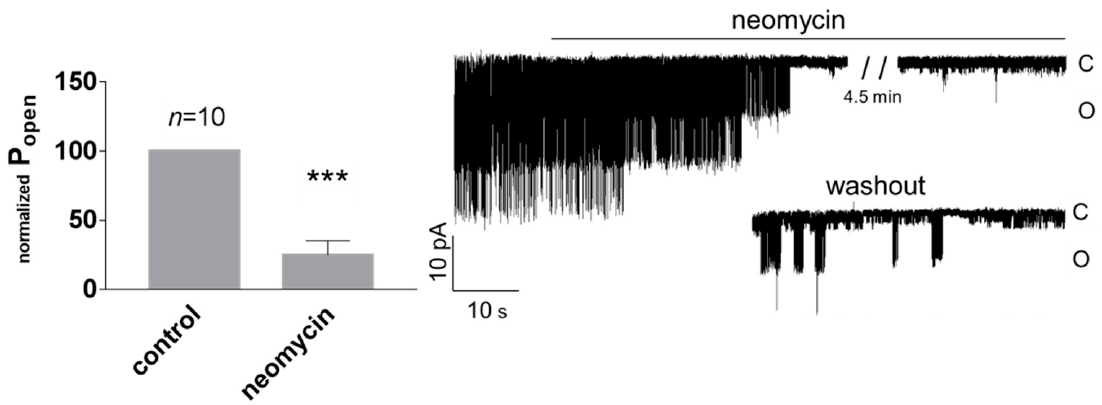
Figure 4. TREK-2-like channels are inhibited by polycationic neomycin (15 µ g/mL) in excised patches. The control solution was exchanged for the solution with neomycin. Both solutions contained 0.1 mM Ca 2+ . P open was normalized in comparison with P open in the control solution, which was set at 100%. P open for recordings at 50 mV and − 50 mV was pooled together. *** p < 0.002, one sample t-test. Original single-channel recordings at − 50 mV at the following conditions: control, neomycin, and washout. The traces were filtered with a low-pass filter set at 1 kHz. Phospholipase C cleaves PI(4,5)P2 to produce second messengers: IP3 and DAG. To further test whether the PI(4,5)P2 ‐ dependent pathway is involved in TREK ‐ 2 ‐ like channel activity, we studied the effect of a phospholipase C activator m ‐ 3M3FBS. M ‐ 3M3FBS de ‐ creases the PI(4,5)P2 pool and activity of ion channels dependent on PI(4,5)P2 within a few hundred seconds [52,53]. We evaluated the changes in channel activity (P open ) over time in the presence of m ‐ 3M3FBS in a bath solution and compared them with changes in the activity in control conditions. P open in the control solution remained approximately unchanged during the recording period (Figure 5), whereas the application of m ‐ 3M3FBS resulted in bimodal change in the channel activity. After ~3 min in the presence of m ‐ 3M3FBS, P open increased, and then, after another period of ~3 min, the activity of the chan ‐ nels significantly diminished. m ‐ 3M3FBS was shown to induce the release of Ca2+ from intracellular stores [54]. When m ‐ 3M3FBS was used in the presence of thapsigargin (Th), no initial increase in P open was observed (Figure 6). Thapsigargin blocks the ability of the cell to pump calcium into the endoplasmic reticula, which results in elevated cytosolic calcium and emptying of intracellular calcium stores. We observed that thapsigargin alone significantly increased the activity of TREK ‐ 2 ‐ like channels (P open ) when applied at high extracellular Ca2+ concentrations (Figure 7). We concluded that the initial increase in P open induced by the application of m ‐ 3M3FBS is due to the increased level of cytoplas ‐ mic calcium, while the subsequent decrease in P open is due to the depletion of PI(4,5)P2. Therefore, we performed experiments to test the possibility that calcium increases the ac ‐ tivity of TREK ‐ 2 ‐ like channels.